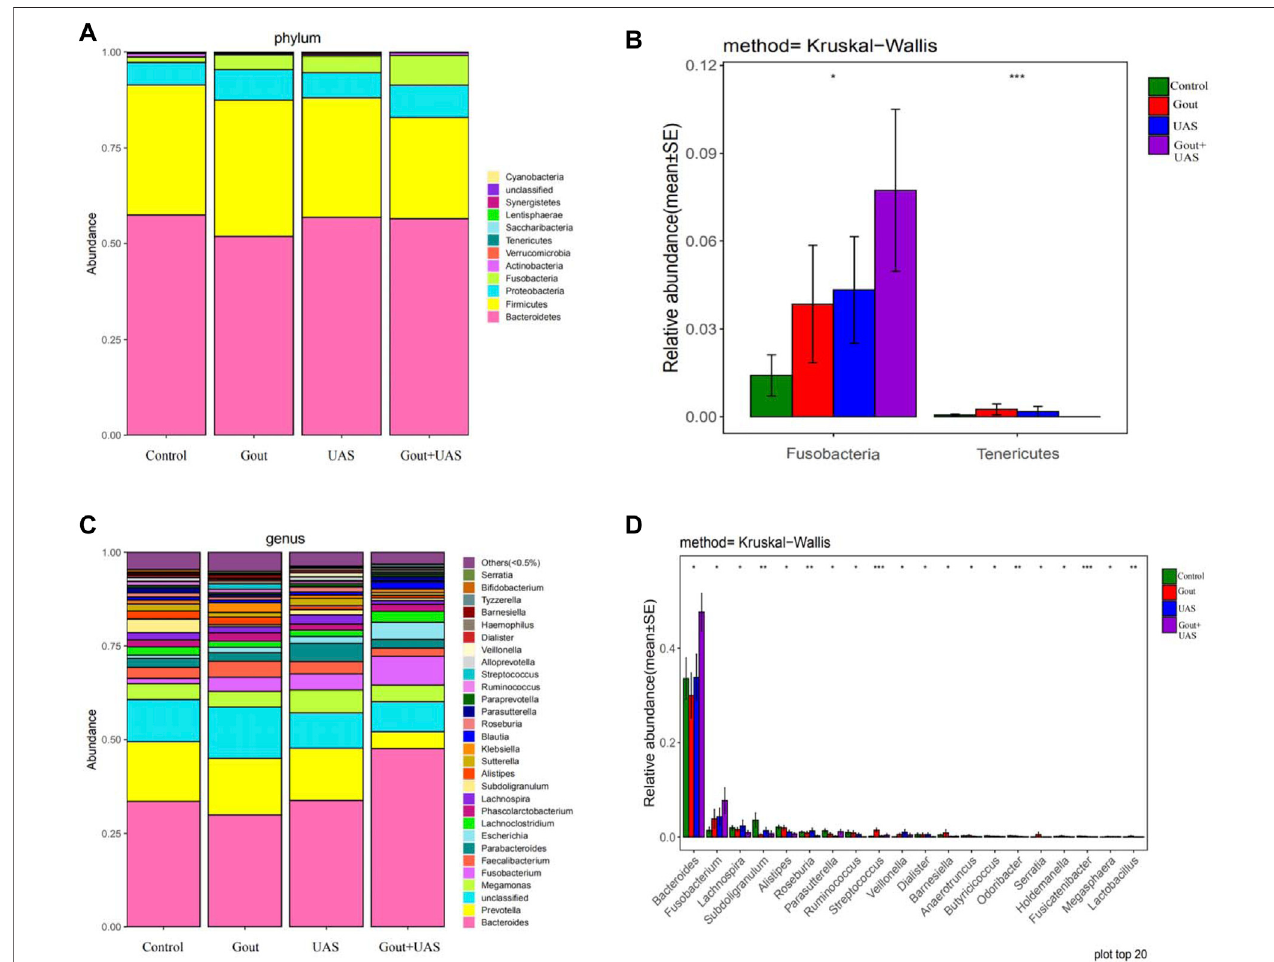
FIGURE2|(A,C) Compositionofgut microbiota between each group at thephylum and genus level. (B,D) Histogramsofdifferences inthe abundance ofspecies analyzed by Kruskal – Wallis test among four groups at the levels of phylum and genus (* p < 0.05, ** p < 0.01, and *** p <